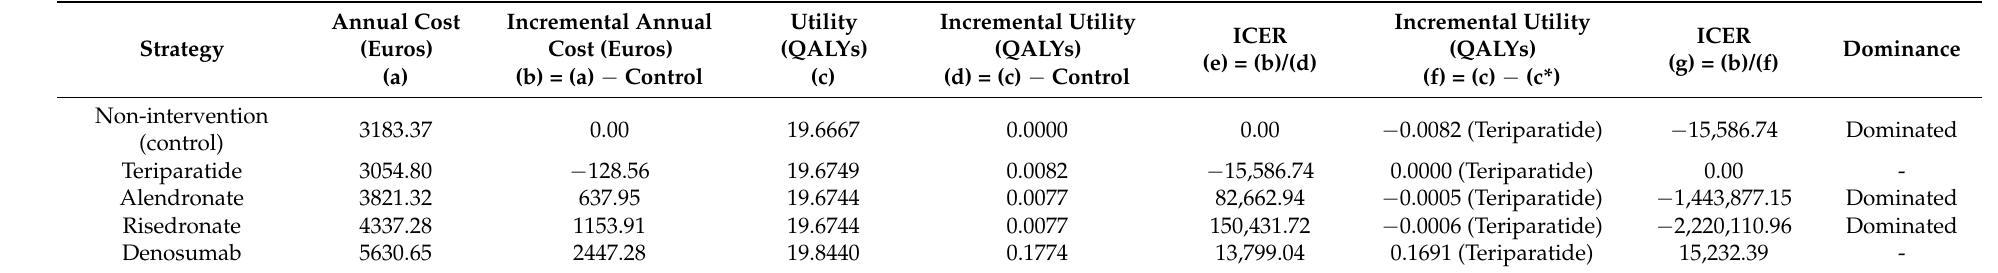
Table 8. The ratio of the increment in cost over the increment in effectiveness (ICER). Extension of denosumab to 10-year